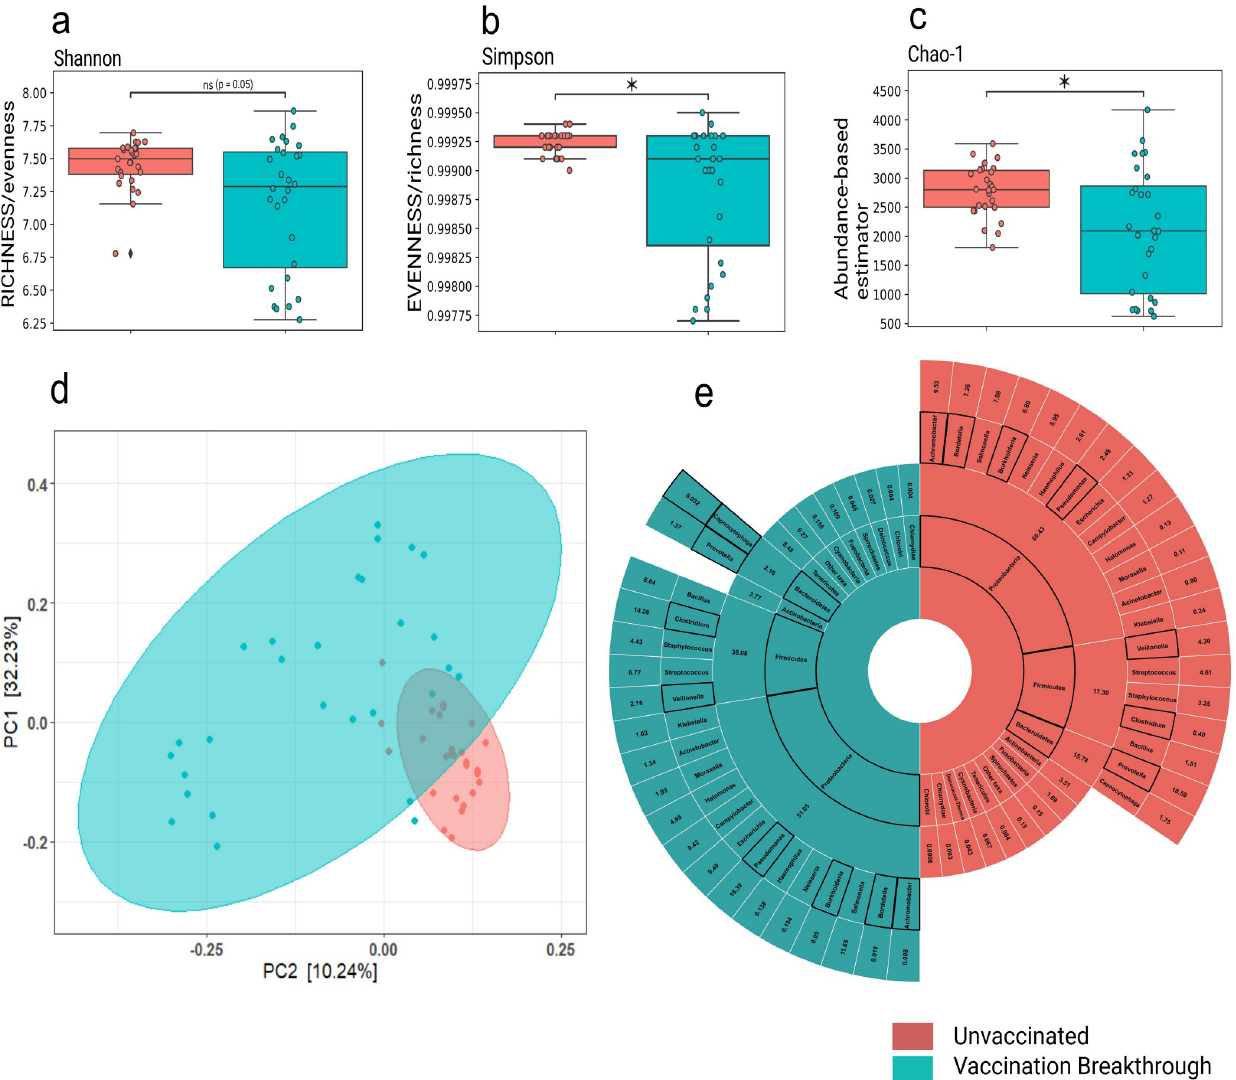
Fig 2. Microbial abundance, richness and evenness distribution across the vaccination breakthrough and the unvaccinated patients. Alpha diversity: a) Shannon (Richness), b) Simpson (Evenness), c) Chao-1 (Abundance-based estimator) showing significant changes in microbiome abundance for vaccination breakthrough and unvaccinated patients, with p-values calculated by the Kruskal Wallis test. d) Beta diversity: Principal Coordinate Analysis (PCoA) shows the differential composition of the nasopharyngeal microbes between vaccination breakthrough and the unvaccinated patients. (e) Illustration of the percent differential abundance of phyla and genera across unvaccinated and vaccination breakthrough cases.